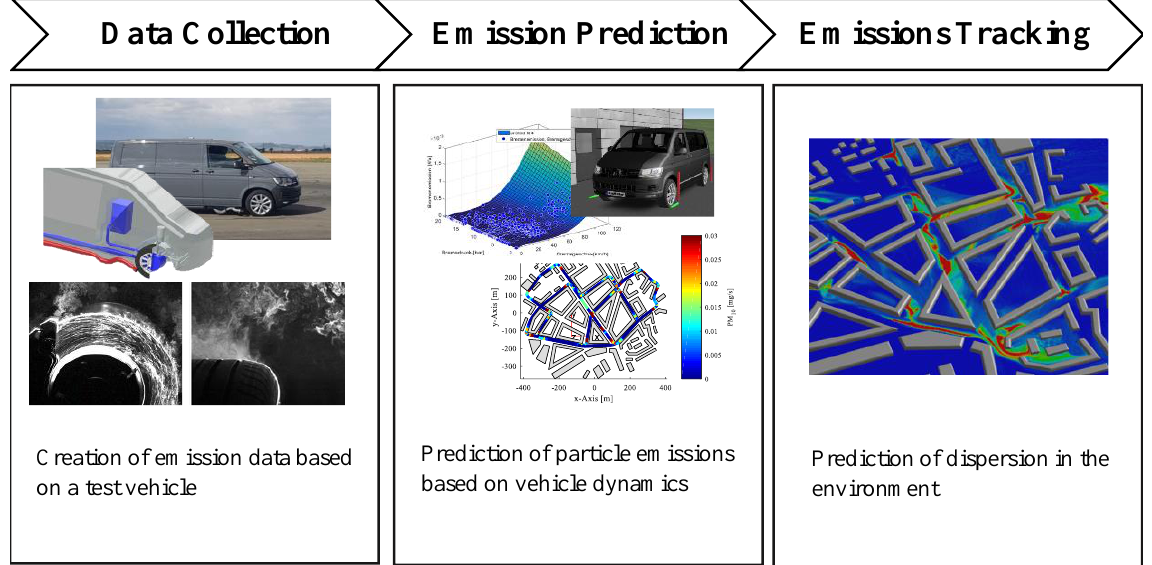
Figure 1. Methodology for particle measurement (creation of a database), virtual emission prediction and particle tracking within the environment.